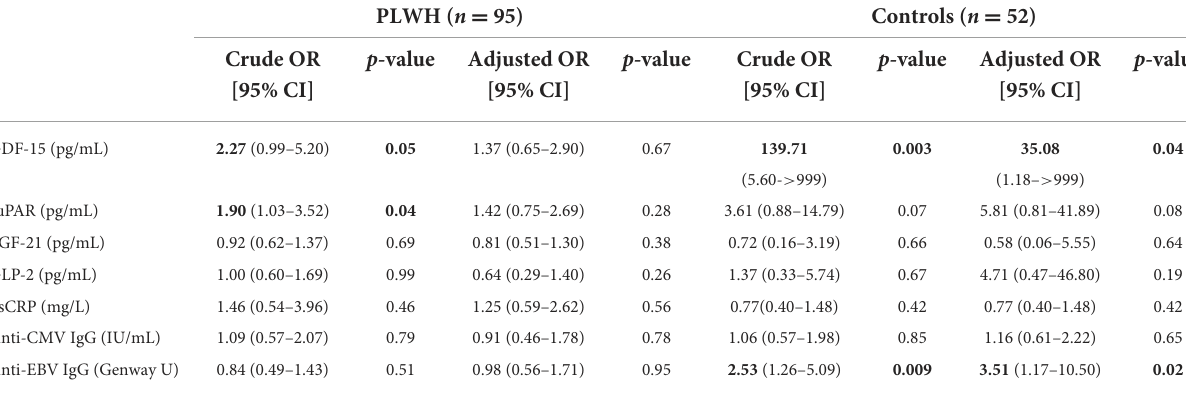
TABLE 4 Crude and adjusted association between biomarkers of interest and presence of subclinical low-attenuation coronary atherosclerosis (LAPV > 0) in participants with and without HIV